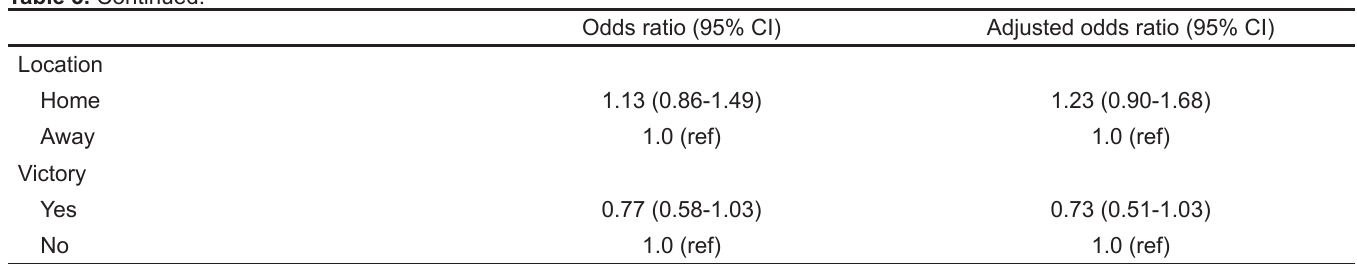
*Adjusted odds ratios obtained via multivariable logistic regression model. CI, confidence interval; ref,